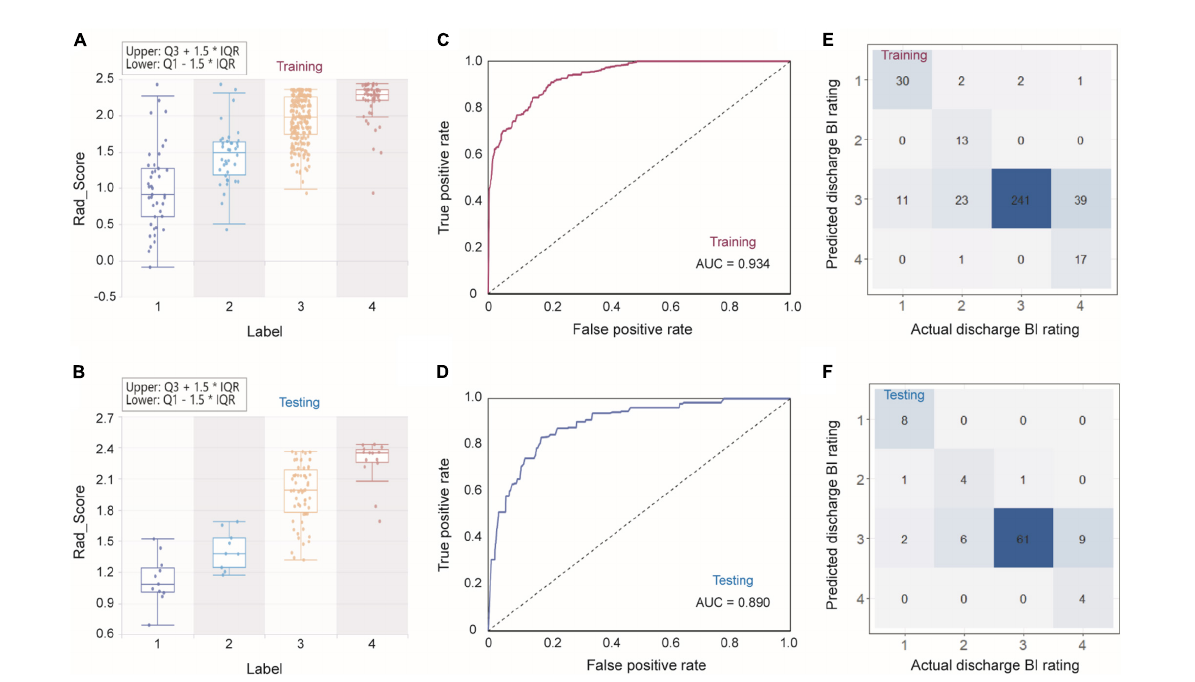
FIGURE4 Combining Rad_Score and Bagging decision tree for predicting discharge BI with four classes. (A,B) Rad_Score distribution within four classes, ROC curves (C,D) , and confusion matrixes (E,F) in the training and testing sets.